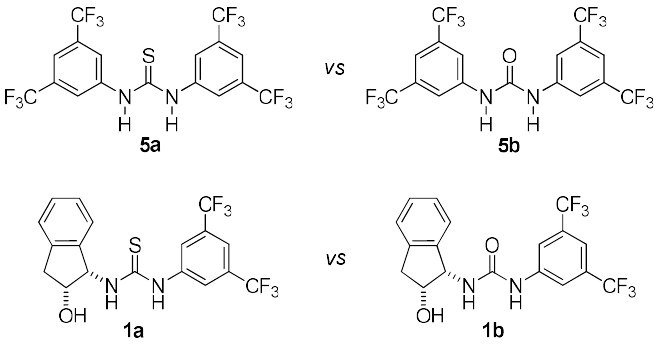
Figure 2. Thiourea and urea catalysts previously tested in Friedel-Crafts-type alkylation reactions.